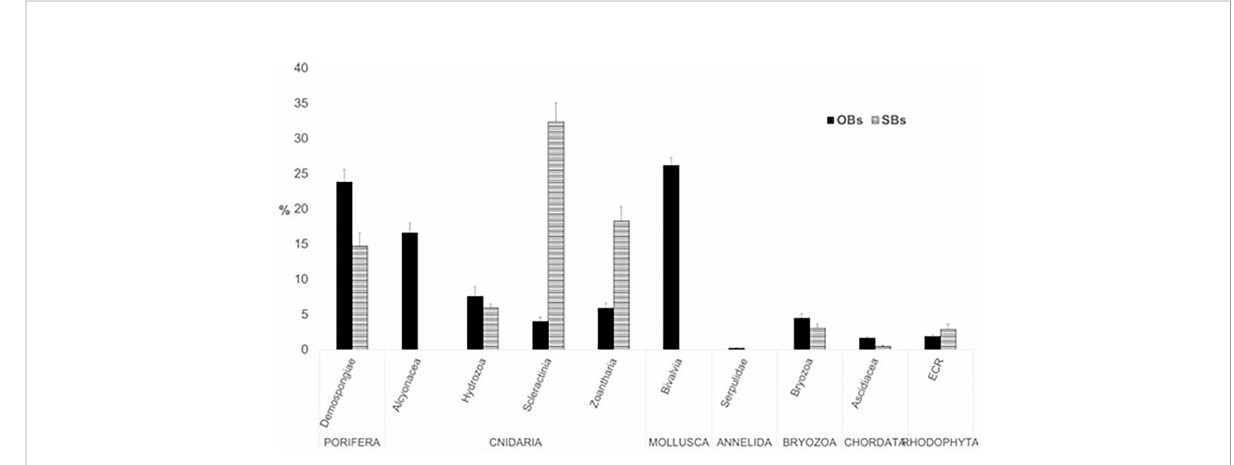
FIGURE 5 Percent covering (mean ± St. Dev. of covering values) of the main epibenthic taxa in the studied mesophotic bioconstructions (OBs, oyster bioconstructions; SBs, scleractinian bioconstructions, ECR, encrusting coralline